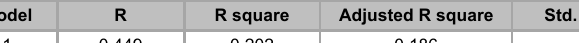
Summary for Model 1